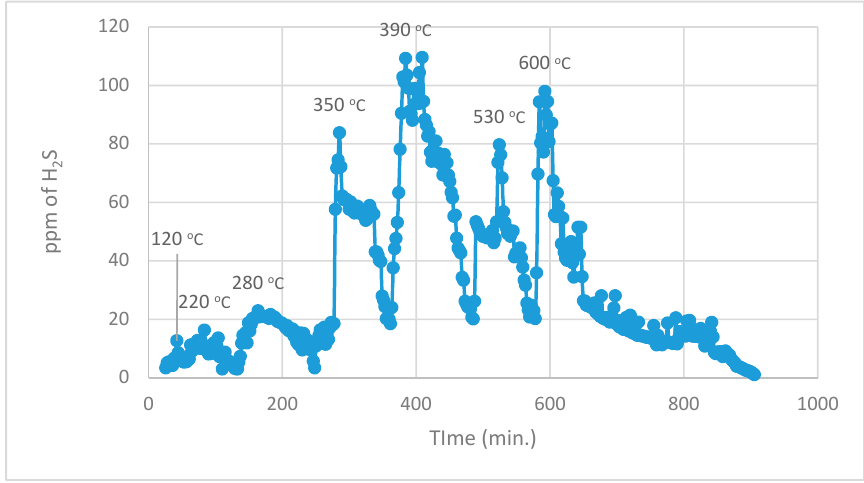
Figure 6. TPR of untreated POW coal. Table 7. Results for the TPR of untreated and treated prince of wales coal.